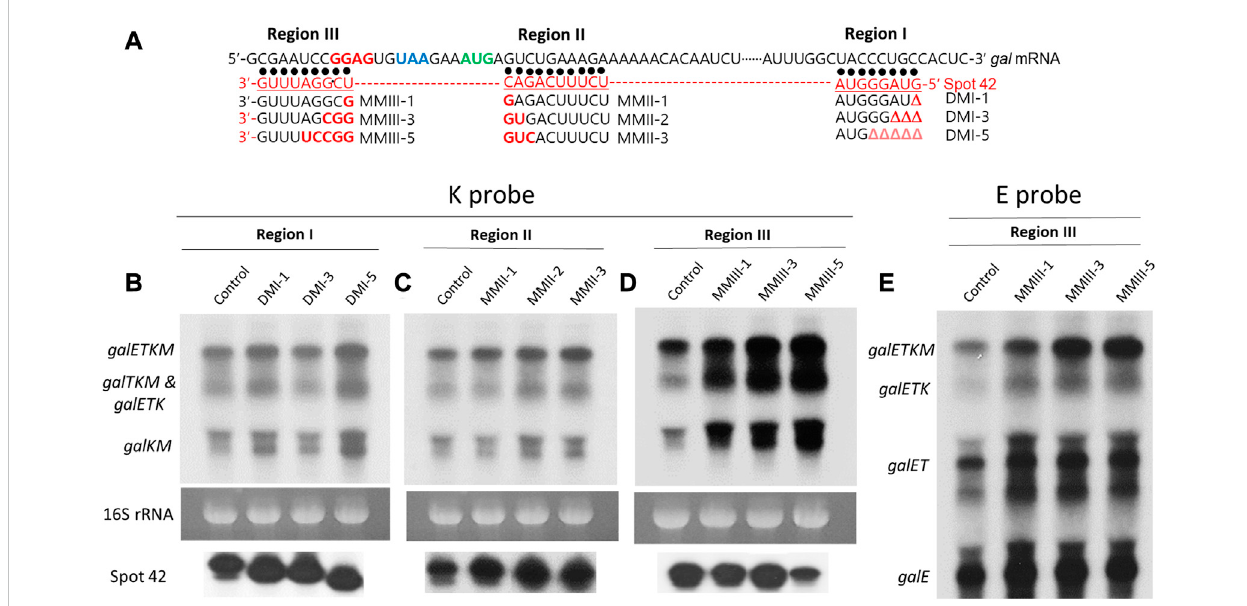
FIGURE 3 Region III of Spot 42 is involved in mRNA degradation of the 3 ′ end-sharing mRNA only. (A) Nucleotide sequence of gal, Spot 42, and Spot 42 mutants. The Shine and Dalgarno sequence for translation initiation of galK is presented in red. The translation stop codon of galT and the translation initiation codon of galK are presented in blue and green, respectively. Also, about 50 nucleotide sequences of the 5 ′ portion of Spot 42 are presented in redbelowthe gal sequence.Thethreeregions ofSpot 42thatform perfectbasepairingswith the gal nucleotide sequences areidenti fi edasregions I, II, and III. Black dots represent base pairing. Spot 42 mutations in each region are listed under the corresponding region by name. Nucleotide changes are marked in red. The region I mutations are nucleotide deletions denoted as Δ in red. (B) K-probed Northern blot of the region I mutant; (C) K-probed Northern blot of the region II mutant; (D) K-probed Northern blot of the region III mutants; (E) E-probed Northern blot of the region III